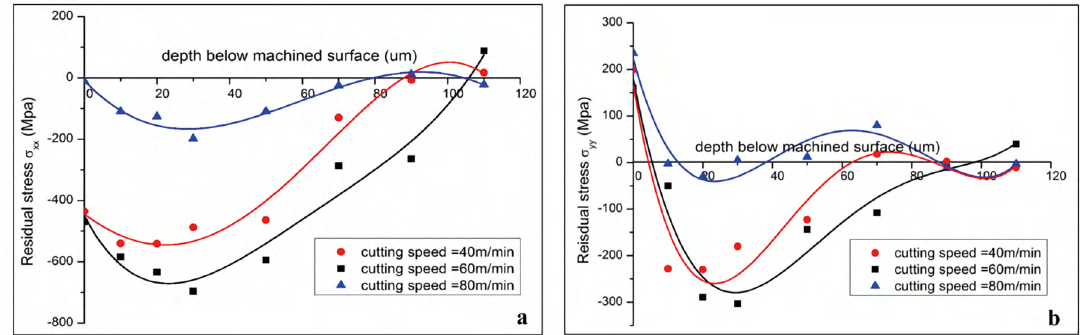
, (b) σ , ( a =0.3mm, a =0.2mm, f =0.06mm/rev, lead angle=10°, tilt xx yy p e